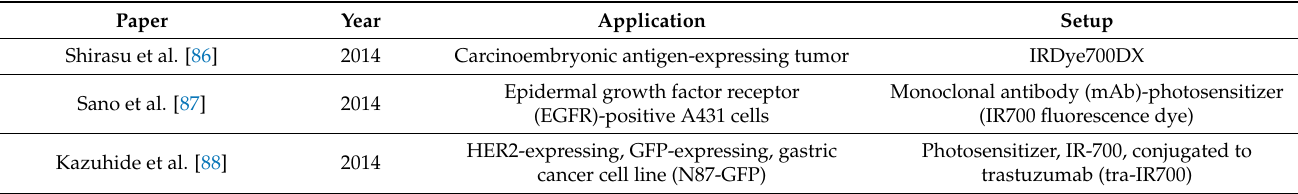
Table 1. NIR-PIT cancer therapy